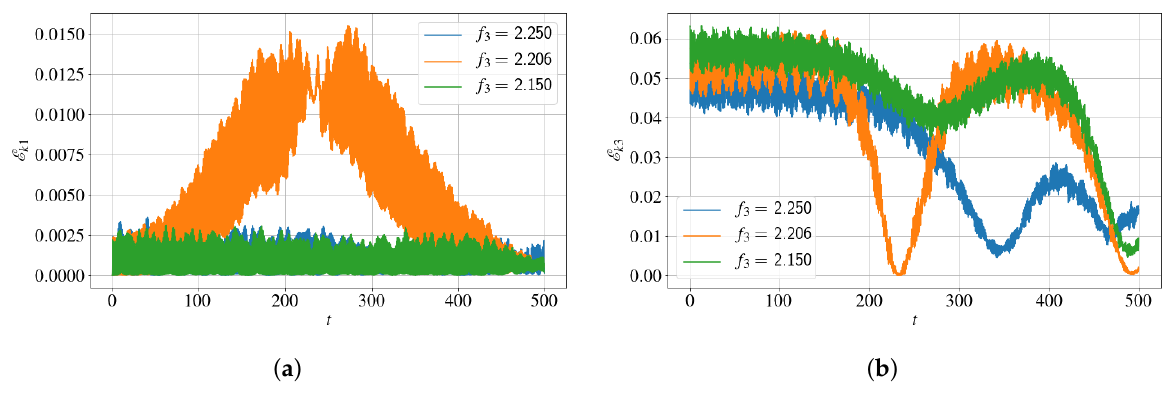
) L and f 3 / Hz = 2.15, K 3 = 1185 2 π L L